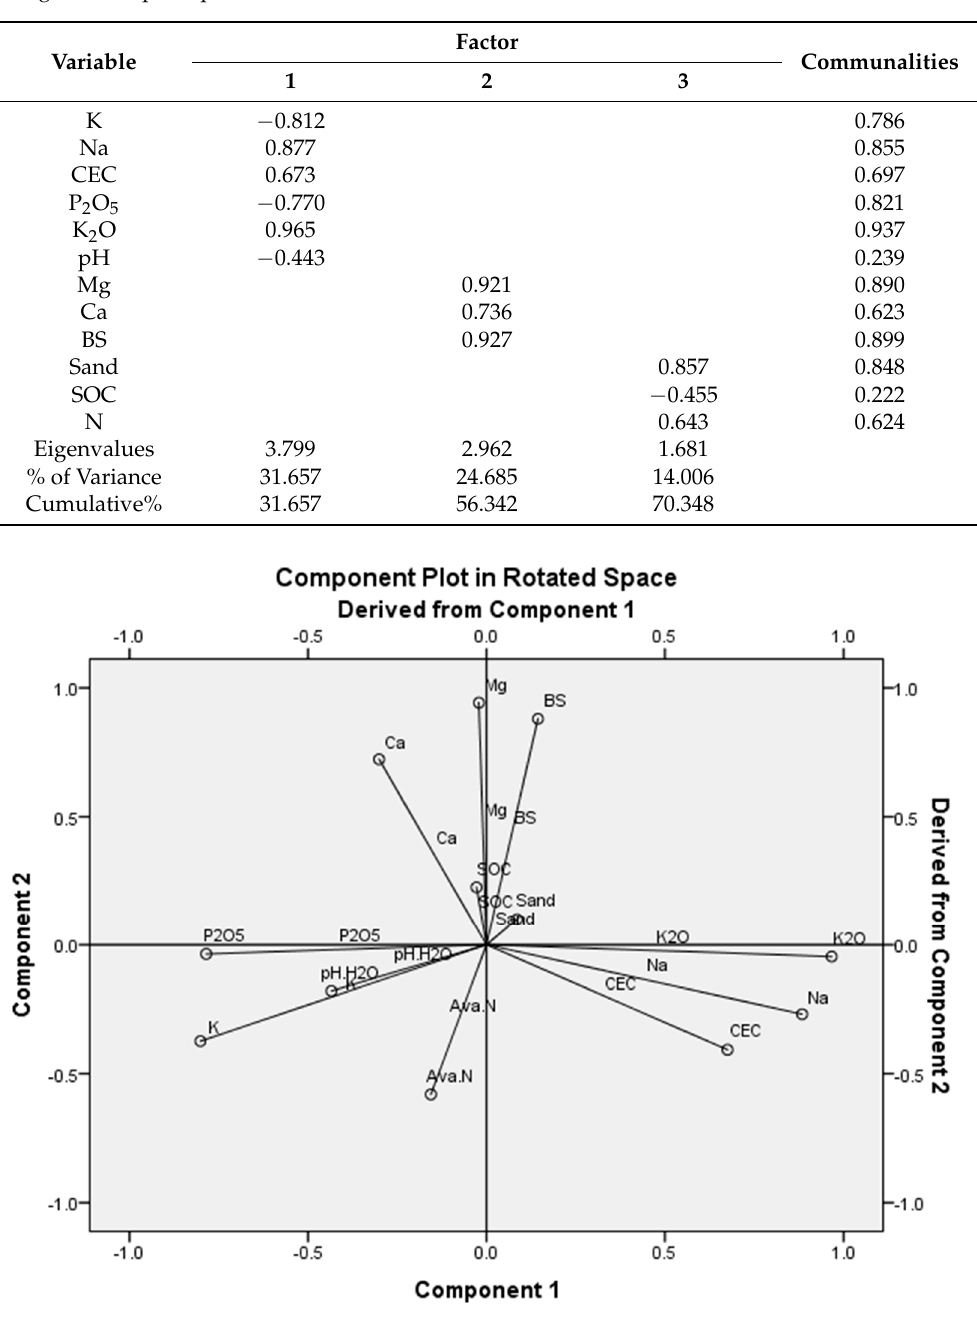
Table 4. Principal component loadings of soil variables derived by principal components analysis using variable principal normalization.